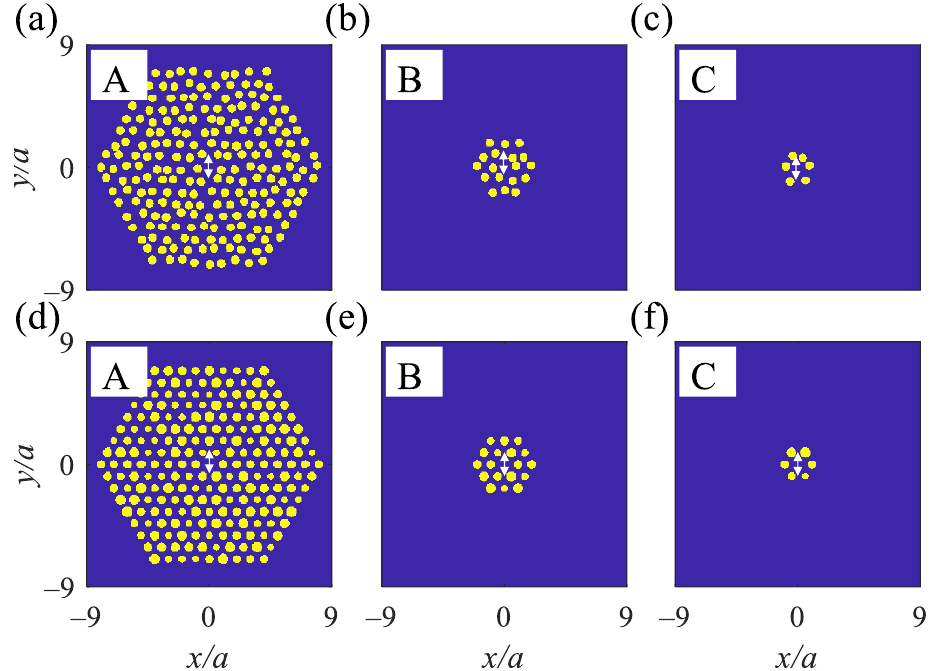
Figure 8. 2D MPHC structure under η p = 19% contains Ag rods in air with a removed rod at the center surrounded by ( a ) eight, ( b ) two, and ( c ) one rings of Ag rods. The structure under η r = 24% containing Ag rods in air with a removed rod at the center surrounded by ( d ) eight, ( e ) two, and ( f ) one rings of Ag rods. Yellow: Ag rods and blue: air. White-double arrows at the center of each cavity show TM polarized dipole sources. Table 4. The average normalized quality factor for the cavity under radius and position